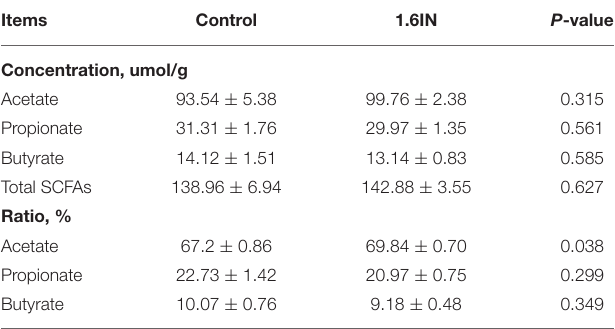
TABLE 3 | The effect of dietary inulin on SCFA composition in the feces of